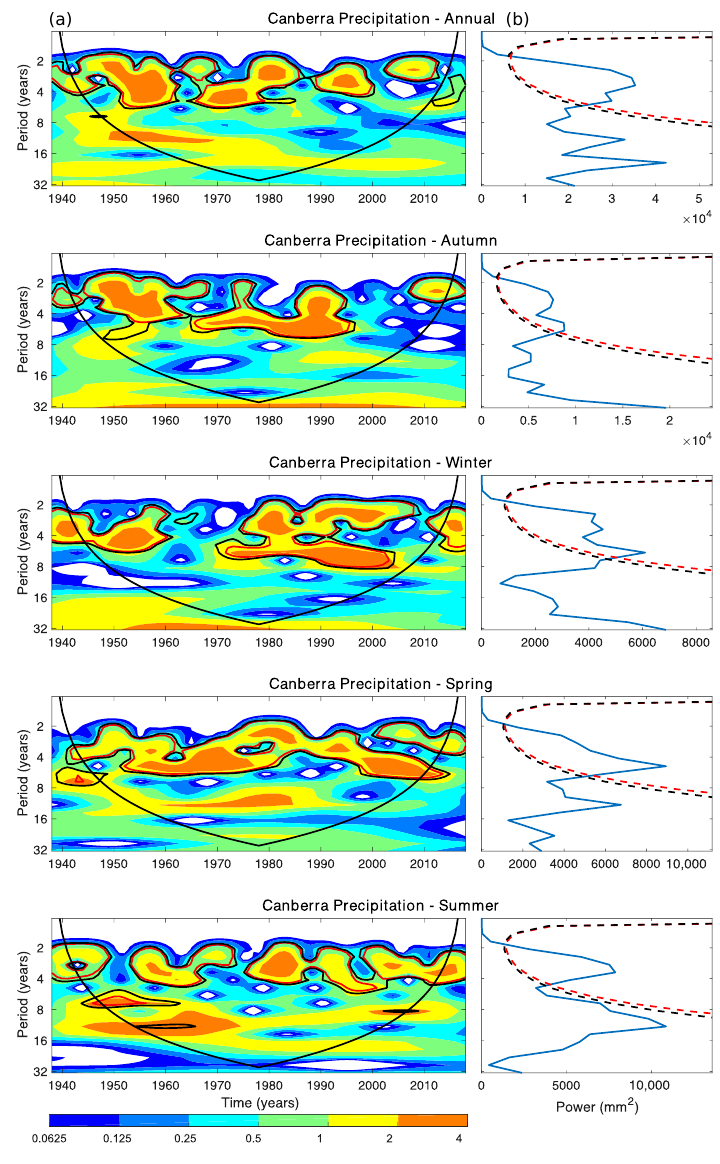
Figure 6. Wavelet analysis for total wet season precipitation for Canberra. Low values (blue) in the wavelet power spectrum ( a ) indicate low periodicity while high values (red) indicate high periodicity. Peaks in the global power spectrum ( b ) on the right panel indicate high periodicity. The dashed/solid red line indicates the 95% confidence level, while the dashed/solid black line indicates the 90% confidence level in each plot. The cone of influence is depicted in the wavelet power spectrum by the solid black